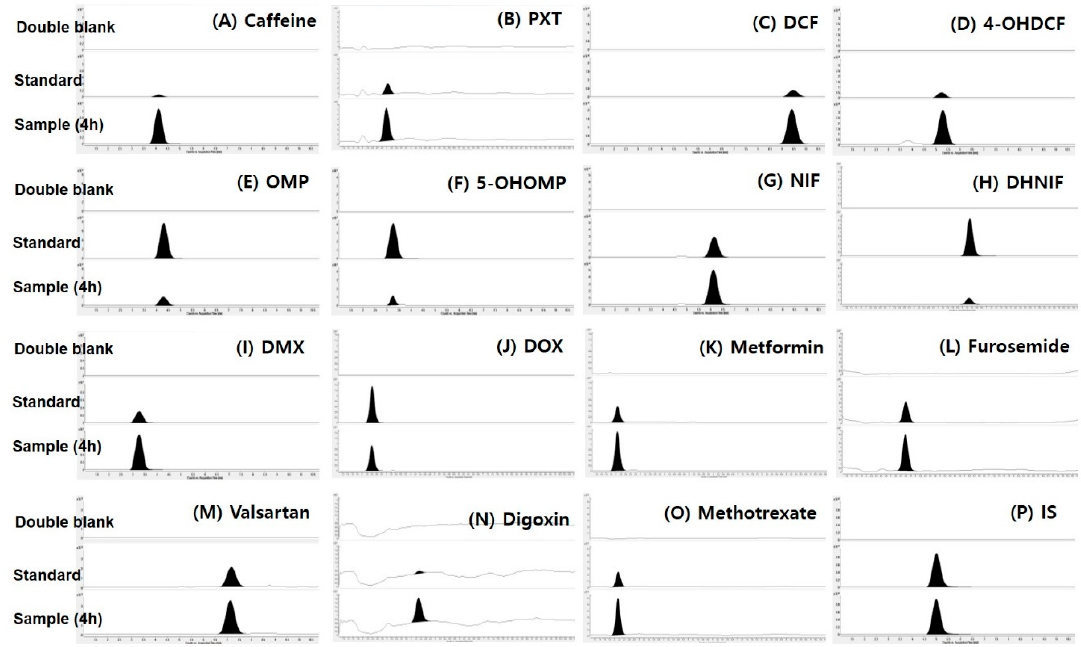
Figure 2. Representative multiple reaction-monitoring (MRM) chromatograms of the the selected probe substrates and metabolites for Cytochrome P450 (CYP) enzymes and substrates for transporters in rat double blank plasma (upper panel), rat blank plasma is spiked with a standard solution (5 ng/mL) of 15 probe substrates or metabolites to rats (middle panel), and rat plasma samples at 4 h following dual cocktail co-administration (lower panel). ( A ) Caffeine, ( B ) paraxanthine (PXT), ( C ) diclofenac (DCF), ( D ) 4-hydroxy diclofenac (4-OHDCF), ( E ) omeprazole (OMP), ( F ) 5-hydroxyomeprazole (5-OHOMP), ( G ) nifedipine (NIF), ( H ) dehydronifedipine (DHNIF), ( I ) dextromethorphan (DMX), ( J ) dextrorphan (DOX), ( K ) metformin, ( L ) furosemide, ( M ) valsartan, ( N ) digoxin, ( O ) methotrexate, and ( P ) berberine (IS).